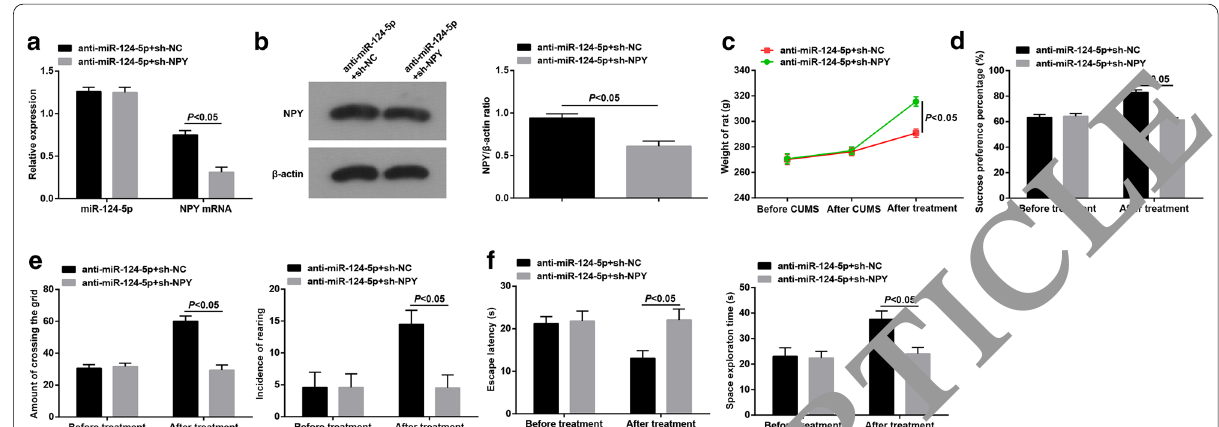
Fig. 7 Knockdown of NPY abolishes the effects of inhibited miR-124-5p on body weight and behavioral function of depressed rats. a MiR-124-5p and NPY mRNA expression in hippocampal tissues after inhibition of both miR-124-5p and NPY by RT-qPCR ( n 6); b NPY protein expression in = hippocampal tissues after inhibition of both miR-124-5p and NPY by western blot analysis ( n 6); c Body weight of depressed rats after inhibition = of both miR-124-5p and NPY ( n 10); d SPP of depressed rats after inhibition of both miR-124-5p and NPY ( n 10); e Frequency of crossing the grid = = and incidence of rearing after inhibition of both miR-124-5p and NPY ( n 10); f Escape latency and space exploration time after inhibition of both = miR-124-5p and NPY ( n 10); Comparisons between two groups were tested by t test =